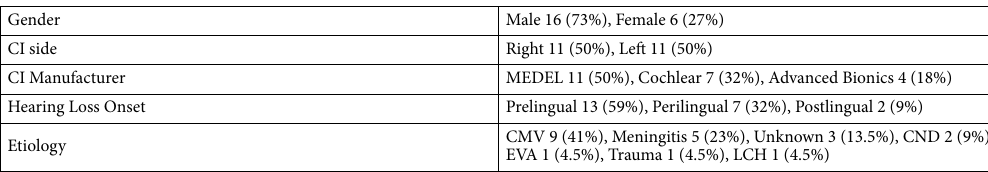
Table 1. Patients’ demographics (n = 22), presenting the number (and percentage) of participants. CMV cytomegalovirus, CND cochlear nerve deficiency, EVA enlarged vestibular aqueduct, LCH Langerhans cell